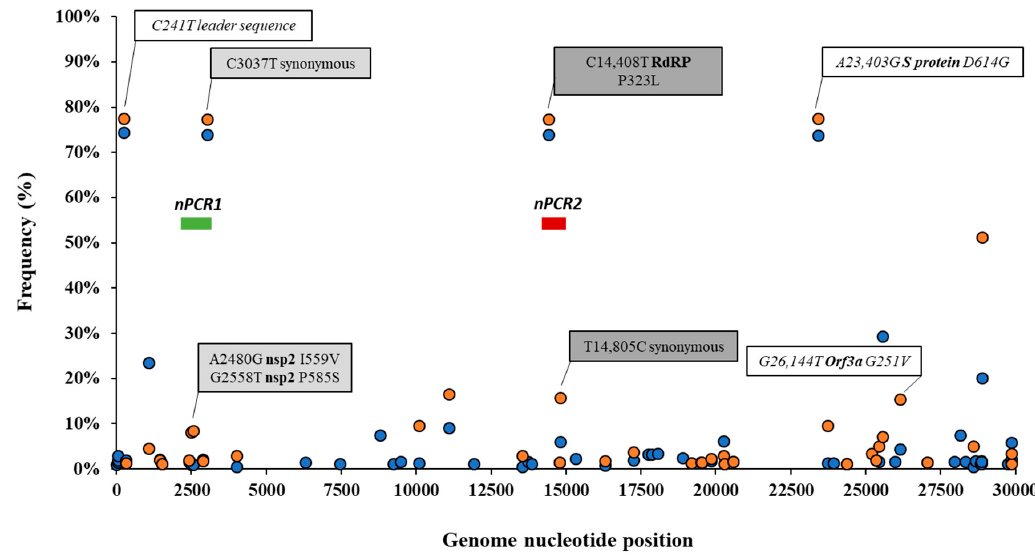
Figure 1. Analysis of nucleotide sequence variation among SARS-CoV-2 RNA sequences from clinical samples. Nucleotide positions at which sequence variation in >1% of viral RNA sequences from England (orange circles) or the rest of the world (blue circles) was observed are shown. Relevant nucleotide positions contained in nPCR1 (light grey shaded box) and nPCR2 (dark grey box) products are shown together with associated nucleotide variations (white boxes) observing very similar frequencies as expected. The genome locations of nPCR1 and nPCR2 products are shown in green and red boxes. The Wuhan-Hu-1 strain (NCBI accession no. MN908947) was used as reference.